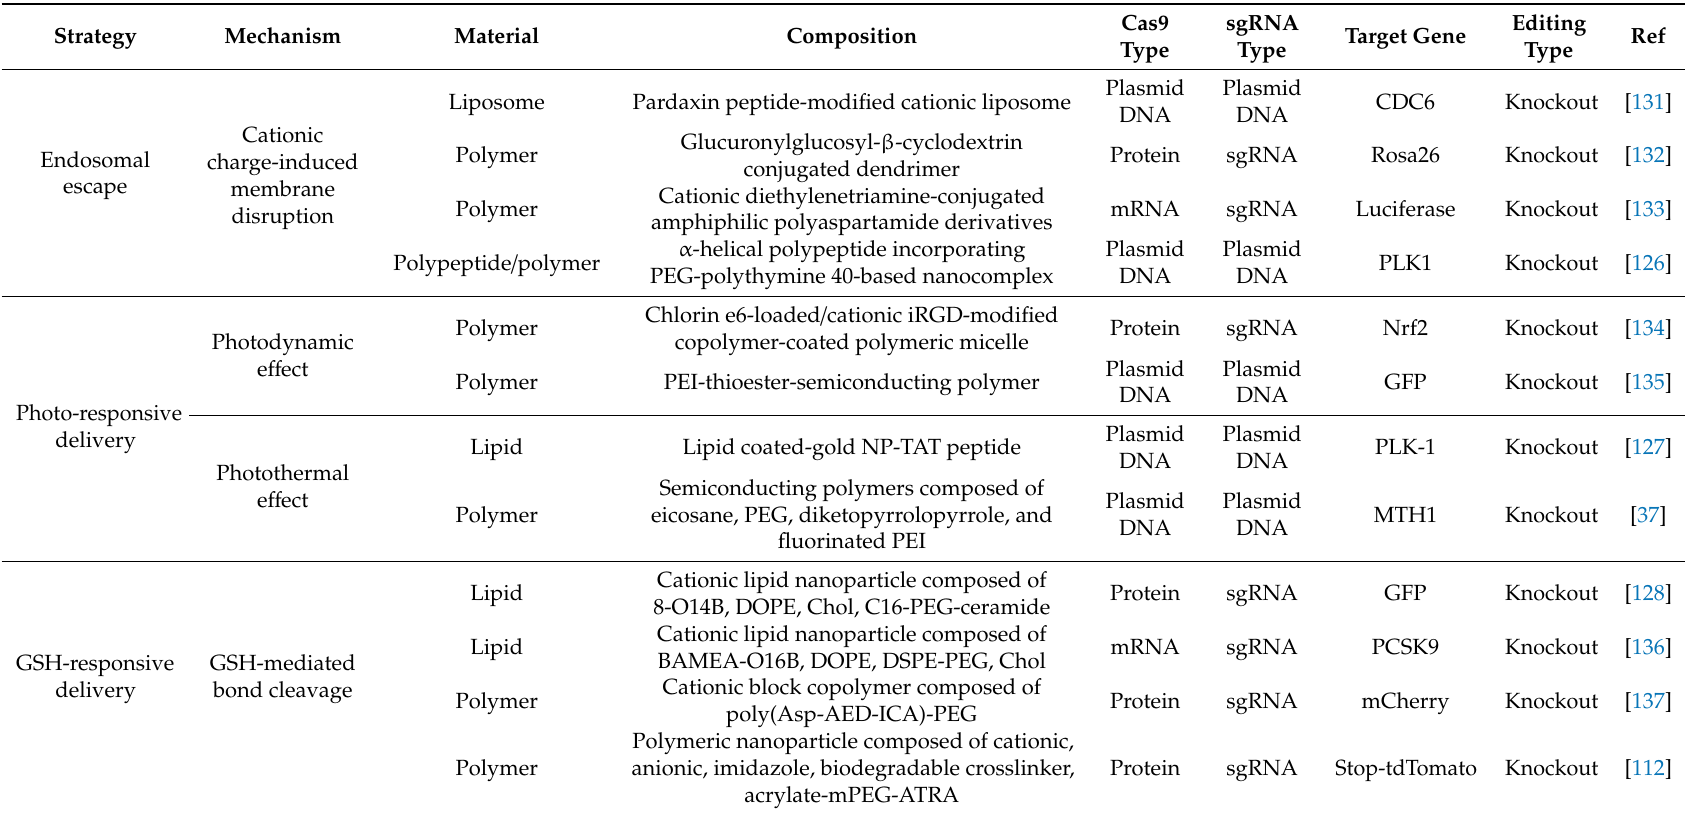
Table 3. Strategies for delivering CRISPR / Cas9 and